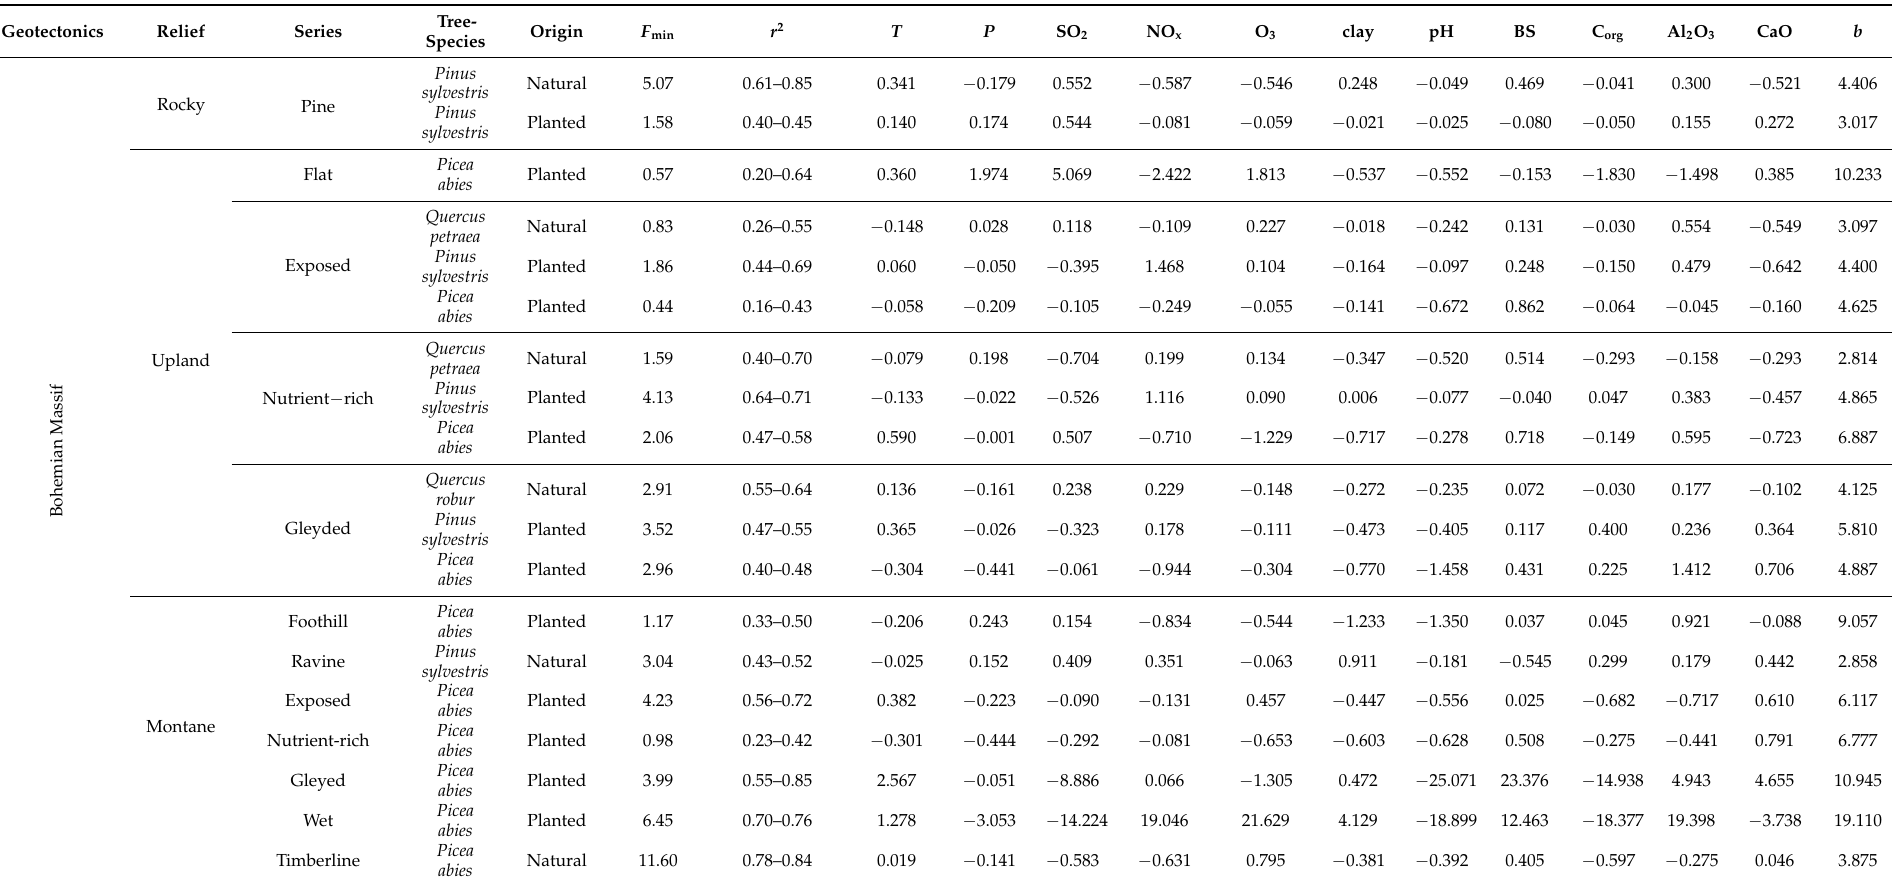
Table 6. Multiple regressions between current basal-area increment and properties of growth conditions at forest stand types (for detail information about properties of growth conditions see Tables 2 and